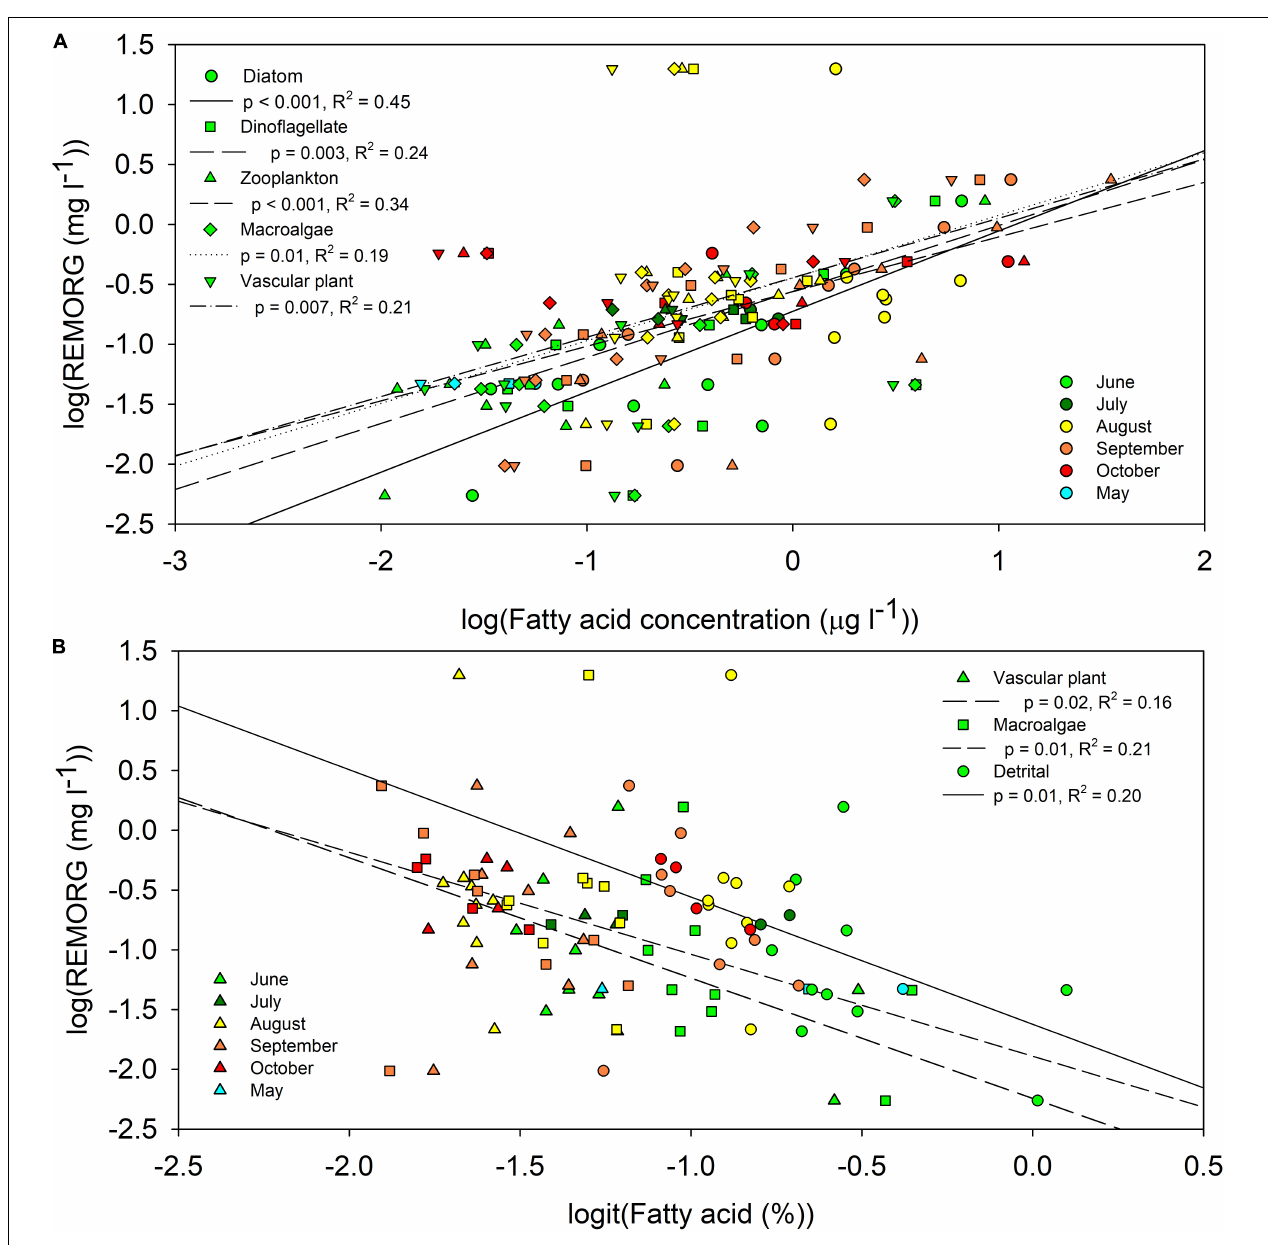
FIGURE 3 | Significant ( p < 0.05) regressions among the REMORG concentration [log(mg l − 1 )] and the (A) concentration [log( µ g l − 1 )] and (B) proportion [logit(%)] of endmember biomarker fatty acids in < 100 µ m particulate organic matter from Saco Bay, ME, United States, throughout 2016 and 2017. Endmembers: